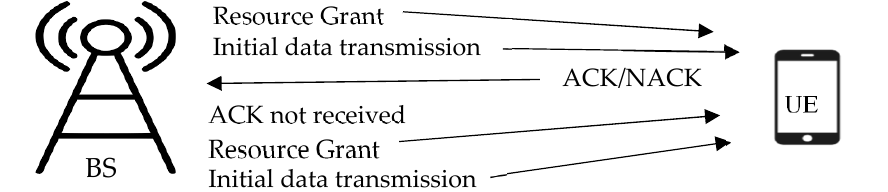
Figure 6. Signaling procedure for downlink data transmission. ACK / NACK, acknowledgment / negative